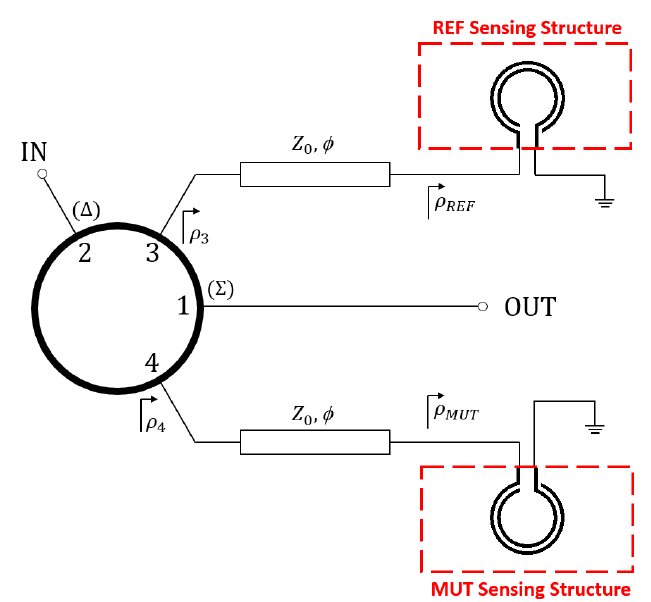
Figure 32. Schematic of the reflective-mode differential sensor based in OSRRs. From [69], reprinted with permission.